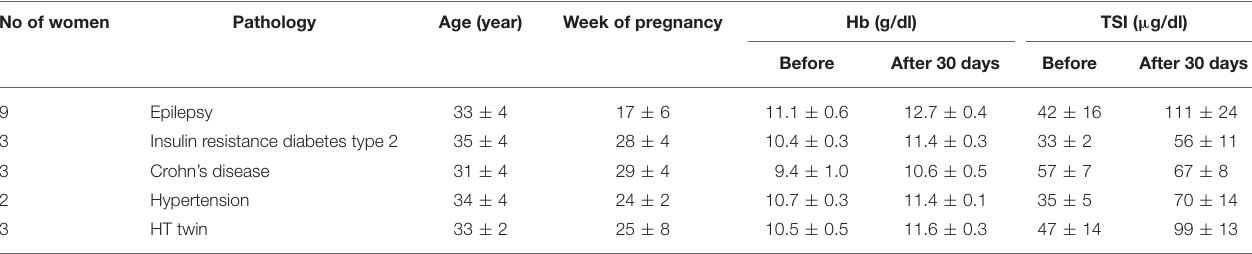
TABLE 8 | Mean values ± SD of hemoglobin and total serum iron of anemic pregnant women suffering from different pathologies treated for 30 days with bovine lactoferrin.